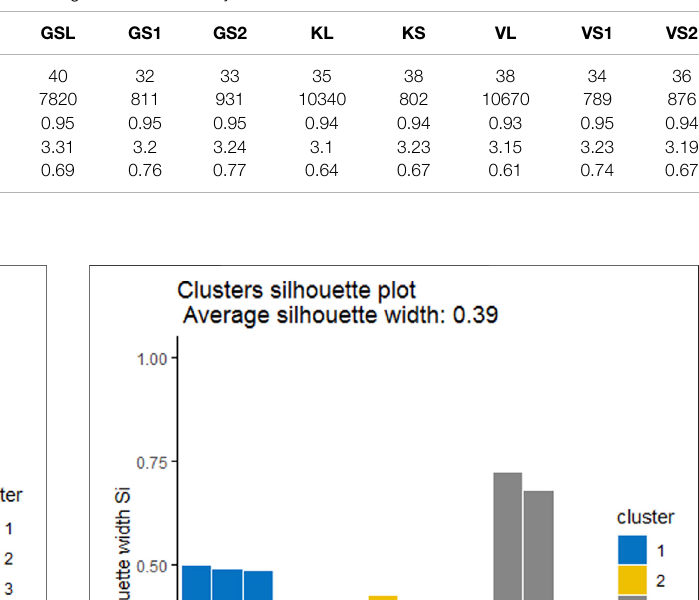
TABLE 5 | Biodiversity indices of planktonic species collected at different sites during the course of study.